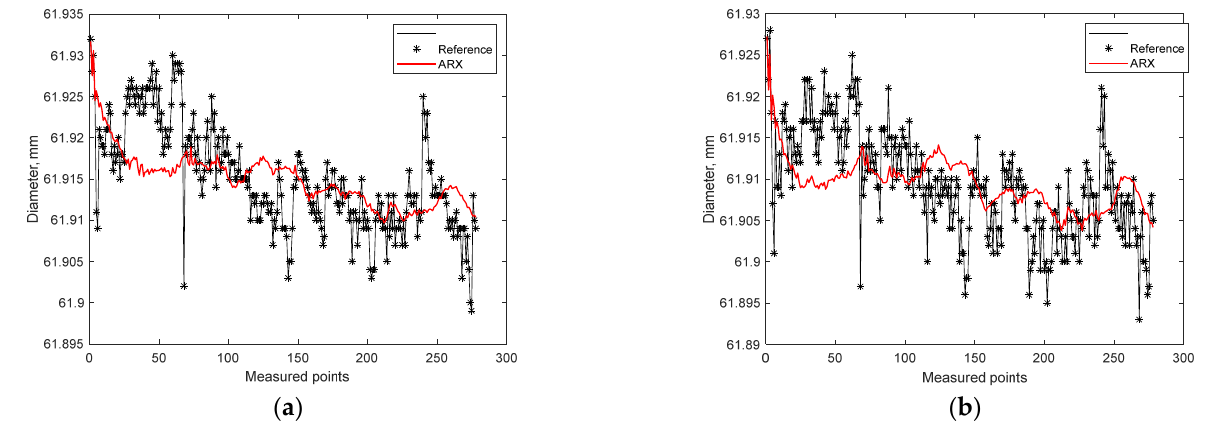
Figure 9. Results of estimation with the use of the ARX model: ( a ) measurement at point A on the workpiece; ( b ) measurement at point B on the workpiece.